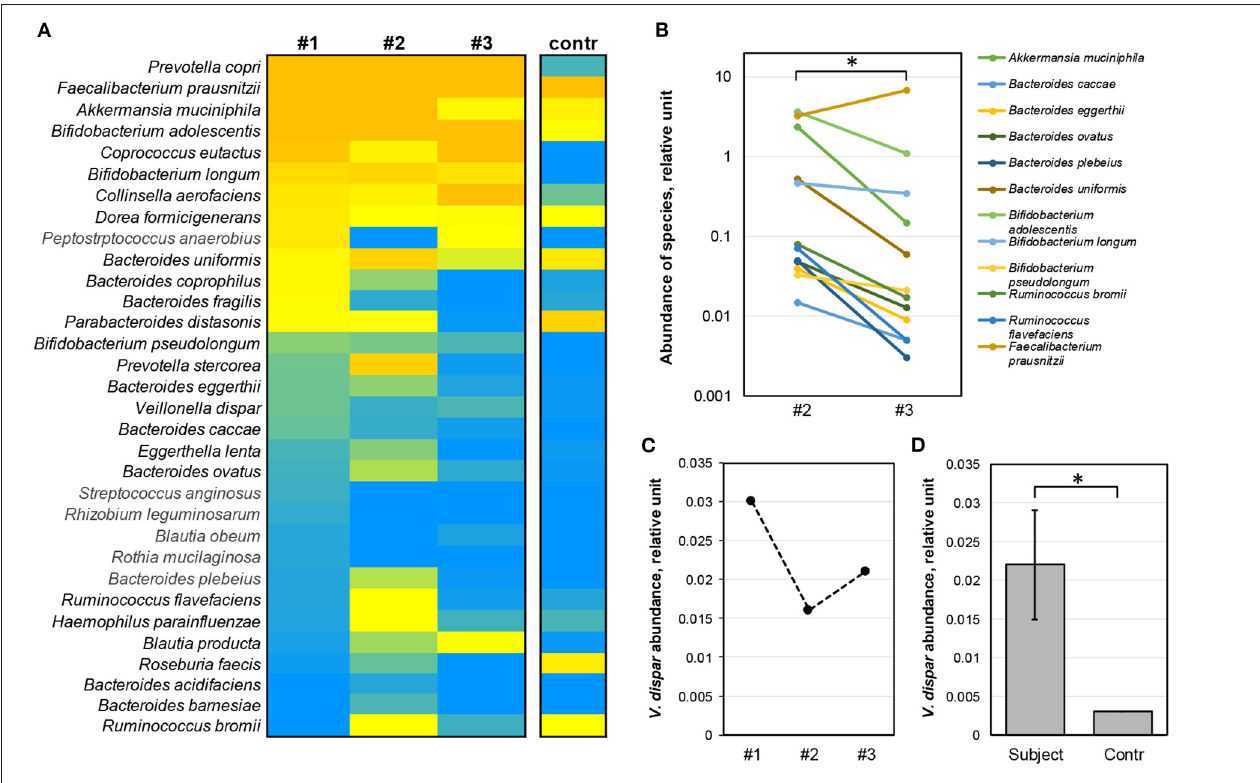
FIGURE 5 | Changes in composition of the 32 most abundant bacterial species during the study period. (A) Dynamic changes in the abundance of observed species in different samples. Relative abundance of specific species ( rows ) in samples ( columns ) are shown in color scale with orange depicting abundance values > 1 RUs, yellow > 0.07, green > 0.03, and blue = 0. (B) Abundance of species with a protective role on the intestinal mucosa ( n = 12) showed a significant reduction after monthly fiber intake (sample #2 vs. sample #3, Wilcoxon rank sum test, p -value < 0.05, denoted by *); y -axis—number of bacterial species, in relative units. (C) Differential changes in the level of abundance of Veillonella dispar (in relative units) before the competition season (#1), after the end of the intensive competition period (#2) and after the fiber intake (#3). x -axis—serial time points; y -axis—abundance, in RU. (D) High abundance of V. dispar in the microbiome under study ( Subject ) was observed as compared with the control group ( p -value < 0.05, single t -test, denoted by *). Bar graph expressed as arithmetic mean of abundance of V. dispar in samples and error bars depicted by standard deviation . y -axis—abundance of V. dispar , in RU. #1, time point week 1 (baseline); #2, time point week 27 (high training and competition period); #3, time point week 31 (after 30 days of dietary supplement